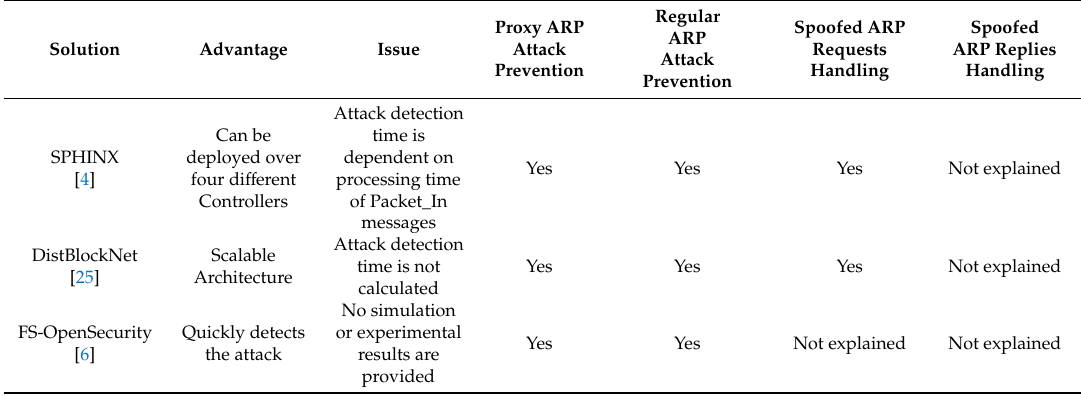
Table 2. Summary of Flow Graph Based